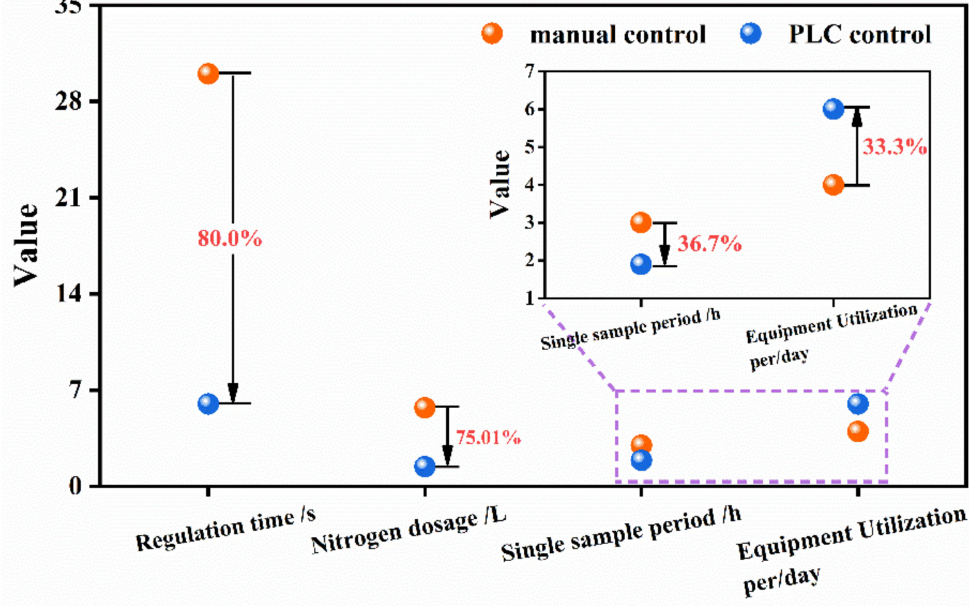
Figure 7. Effect of PLC control vs. manual control.4 Exploitable